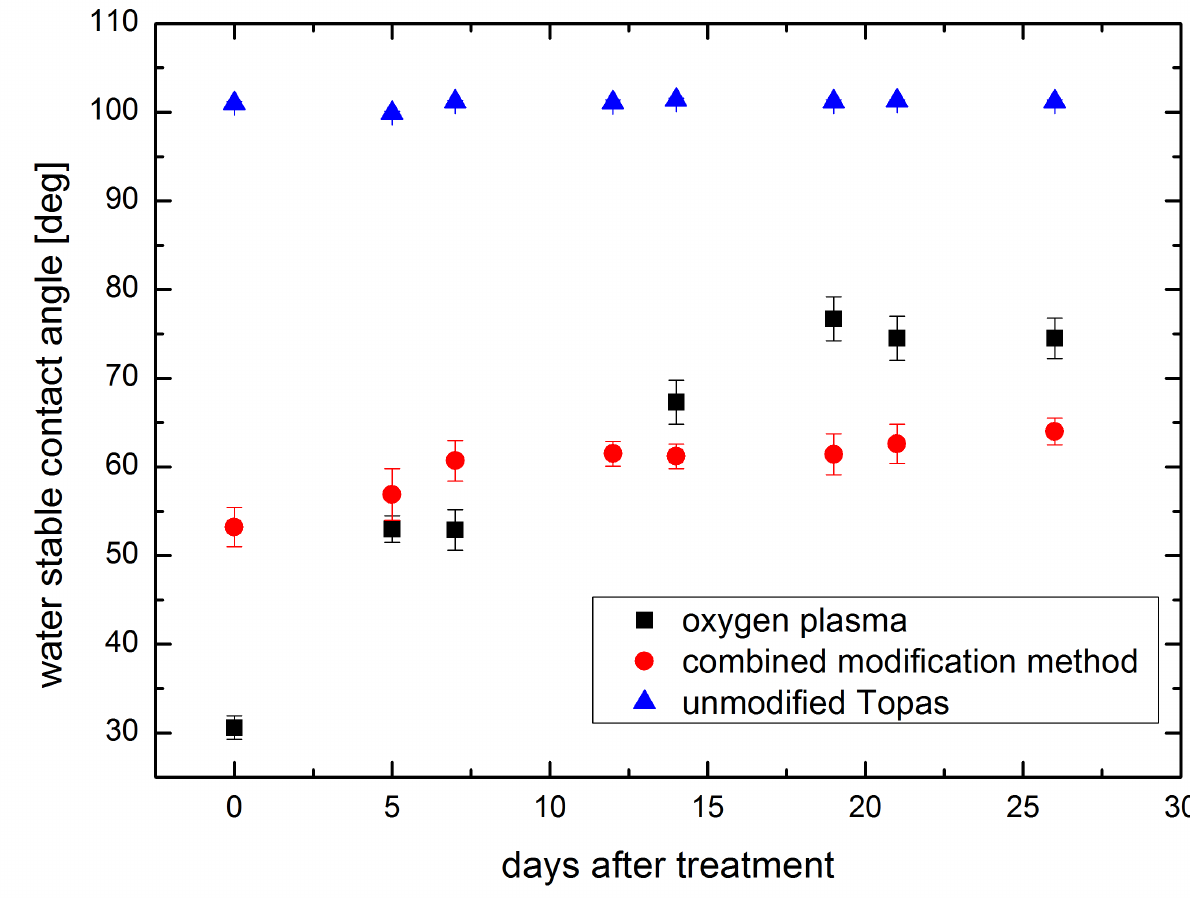
Figure 3. The graph of stability of hydrophilic Topas (cid:114) treatment over time. The Topas (cid:114) treated with oxygen plasma has a low initial contact angle which increases rapidly to 70 ◦ . Topas (cid:114) modified with combined technique has a contact angle around 53 ◦ which is stable over the period of 3